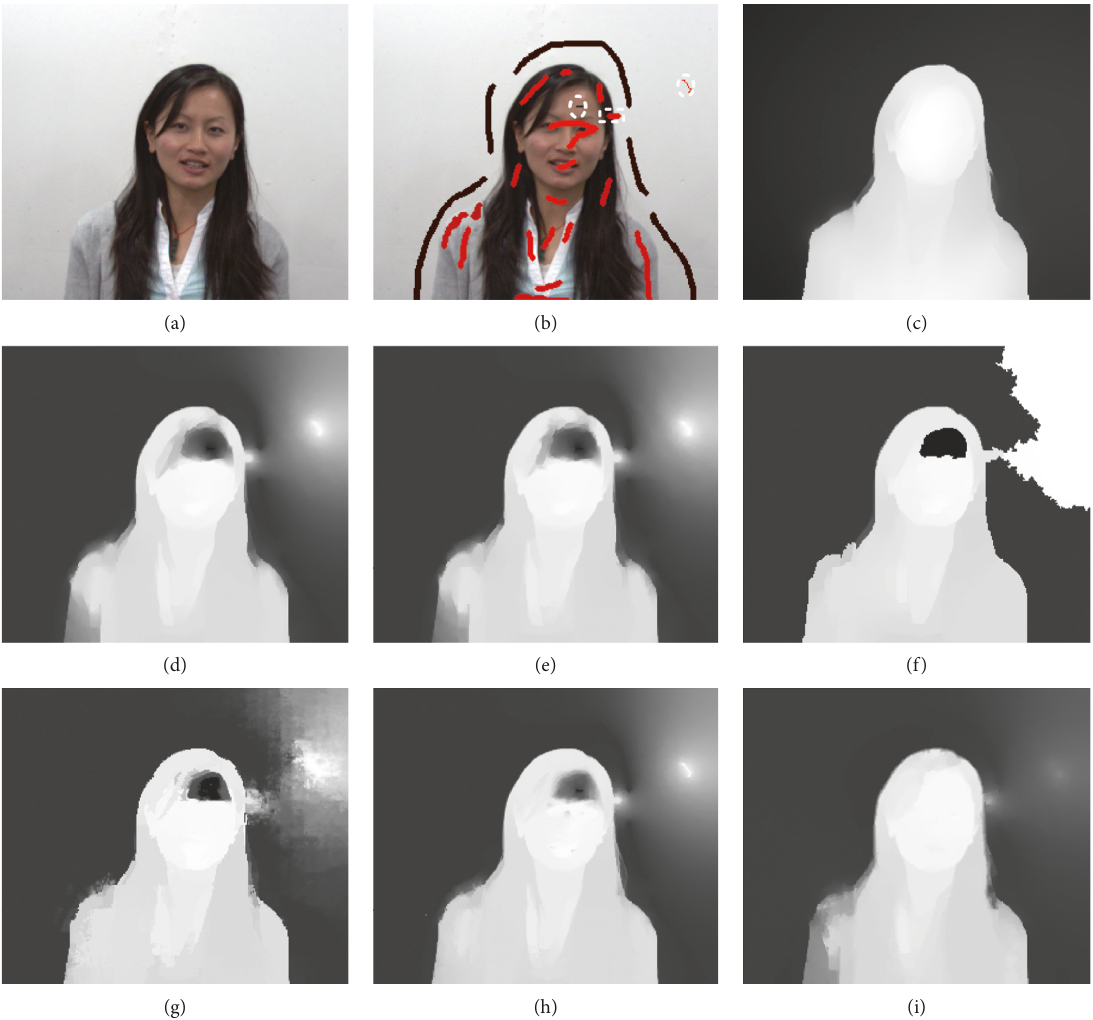
Figure 9: Results for RGBZ_03 in the presence of inaccurate scribbles. (a) Input image. (b) User scribbles. (c) Groundtruth. (d) Depth of RW [4]. (e) Depth of OPT [6]. (f) Depth of HGR [10]. (g) Depth of SOPT [13]. (h) Depth of NRW [14]. (i) Depth of proposed.